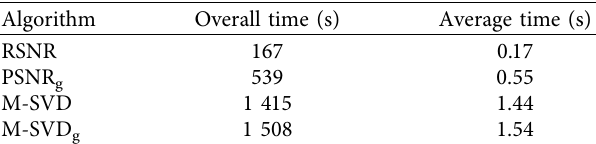
Table 4: Comparison of real-time performance of the improved algorithms.